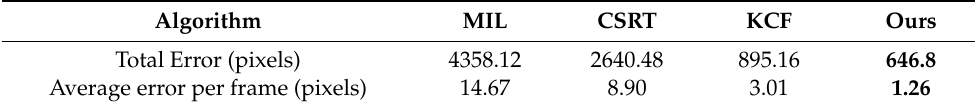
Table 10. Error value statistics for four vehicle trajectory extraction